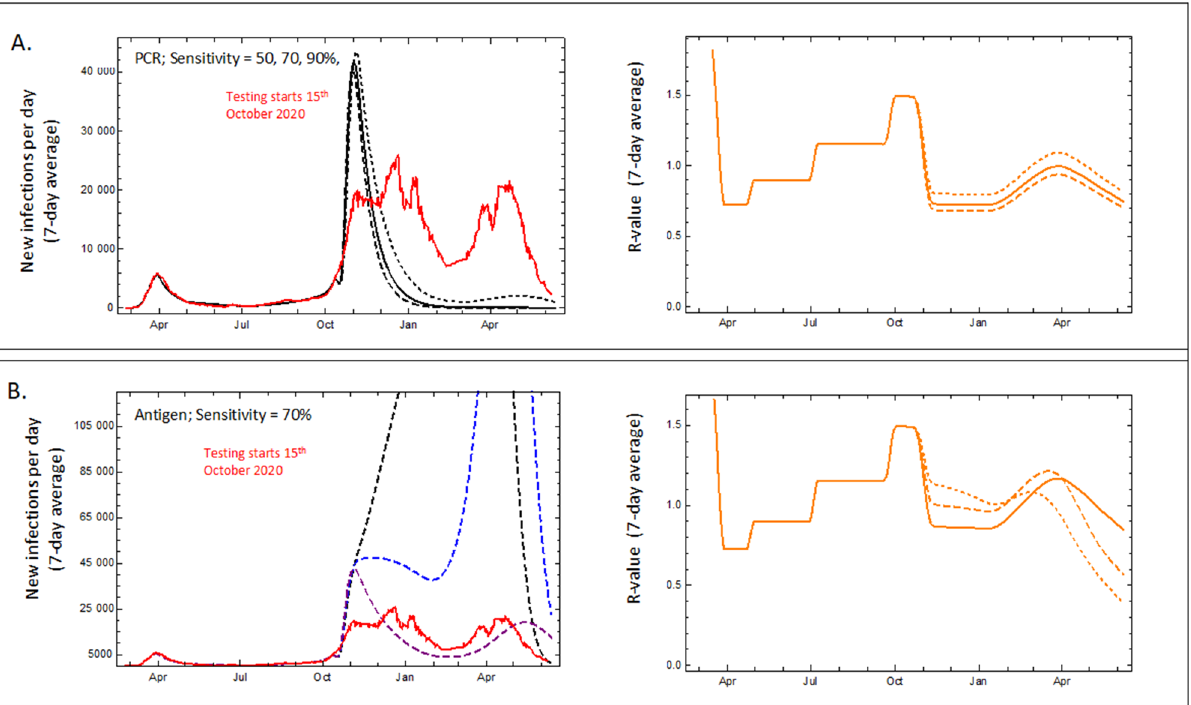
Figure 3. Modelling the impact of population-scale testing in Germany. Graphs show the comparison of the development of registered daily new infections (7-day averages) of John Hopkins University data for Germany (red line) with model values. The model assumes daily testing starting Oct 15 2021, gradually increasing participation up to 60% of the population after 30 days. ( A ) (PCR) daily testing of 60% of the population with sensitivity 50% (dashed), 70% (solid line), 90% (dotted). Left: daily registered newly infected. Right: R-value. ( B ) (Antigen) daily testing of 60% of the population with sensitivity 70% under the assumption of test effectiveness delayed with respect to PCR tests by 1, 2 or 3 days. Left: expected daily new infections with delay by 1 day (purple), 2 days (blue), respectively 3 days (black). Right: corresponding